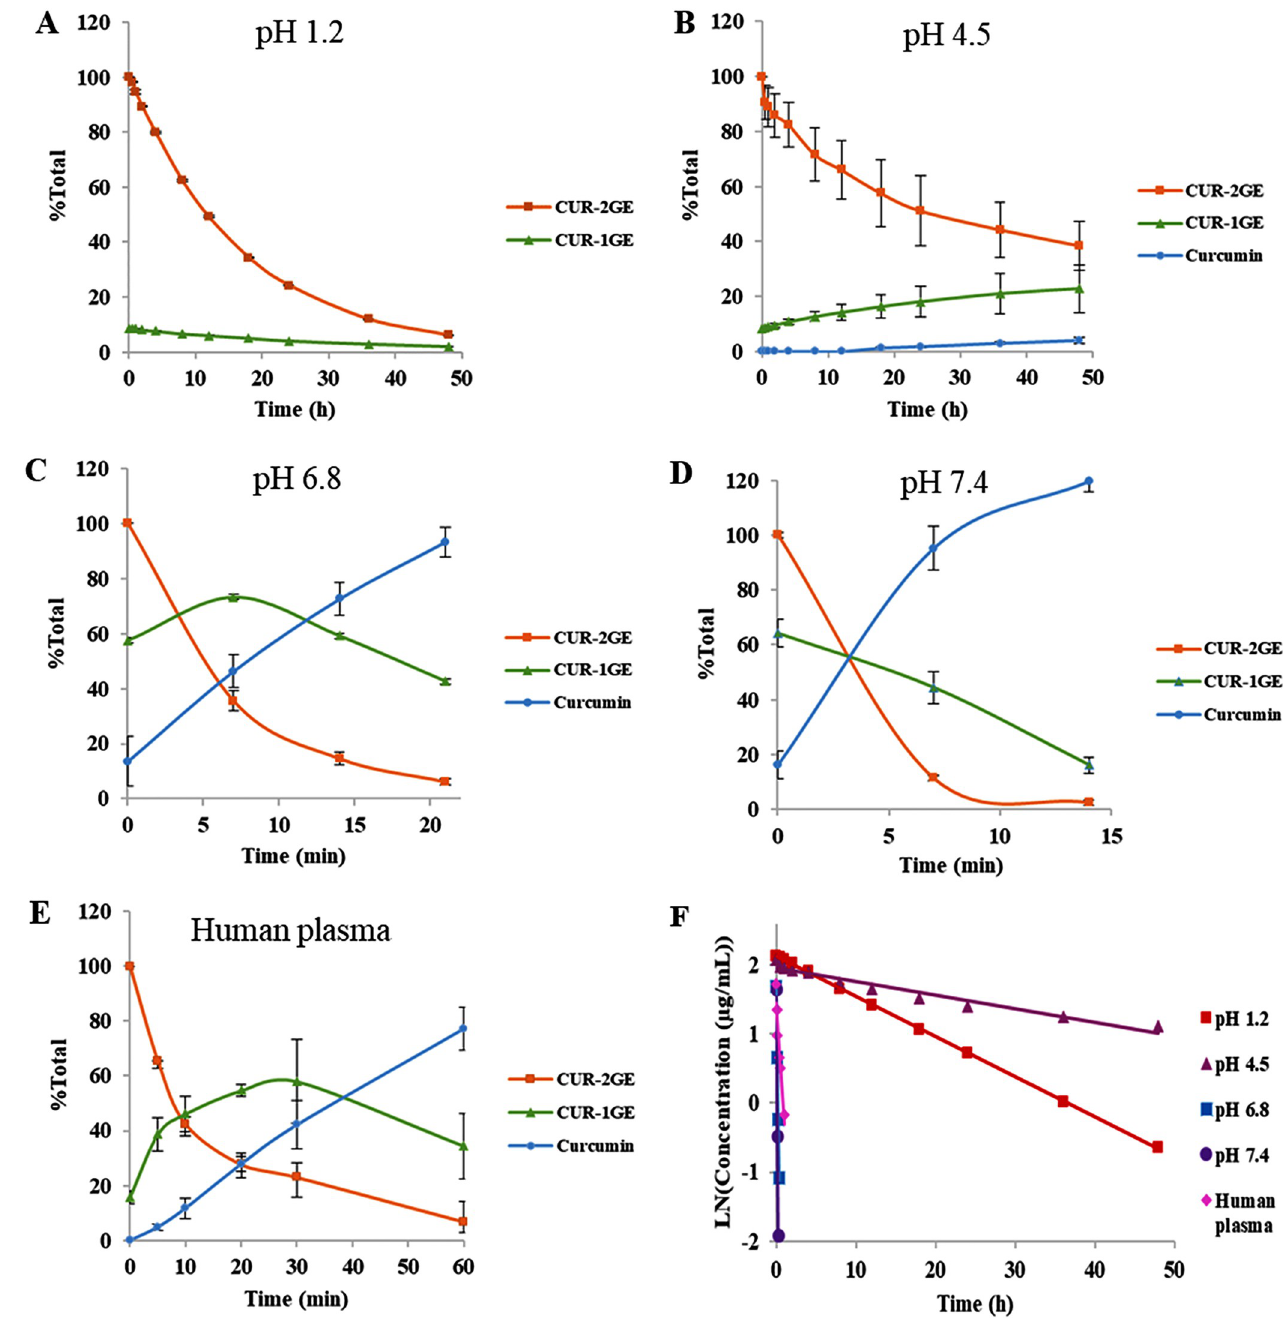
Fig 3. Chemical stability of CUR-2GE in various buffers and human plasma. Kinetic profiles of CUR-2GE and its hydrolytic products in buffers and human plasma: (A) pH 1.2, (B) 4.5, (C) 6.8, (D) 7.4 and (E) human plasma. Data of CUR-2GE and its hydrolytic products are expressed as the percentage of the initial peak area of CUR-2GE (%Total). (F) Pseudo-first-order kinetic plots of CUR-2GE hydrolysis in buffers and human plasma. greater than the previously reported values of curcumin ranging from 2.19 to 3.29 [18, 59–61]. The increased log P confirmed that the presence of the GE-promoities at both phenolic groups of curcumin contributed to the higher lipophilicity of CUR-2GE as designed.